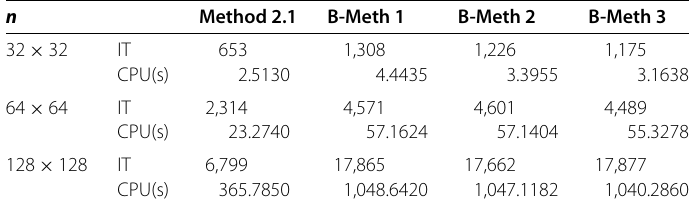
Table 3 The comparison of computational results between Method 2.1 and Basic Method